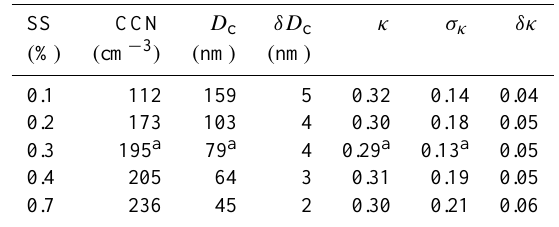
Table 1. For time periods where local land-based sources can be ruled out: the median CCN number concentrations, the median crit- ical diameters ( D c ), the average random error on D c ( δD c ), median κ values, standard deviations of the κ values ( σ κ ) and average ran- dom errors on the κ values ( δκ ) for the different